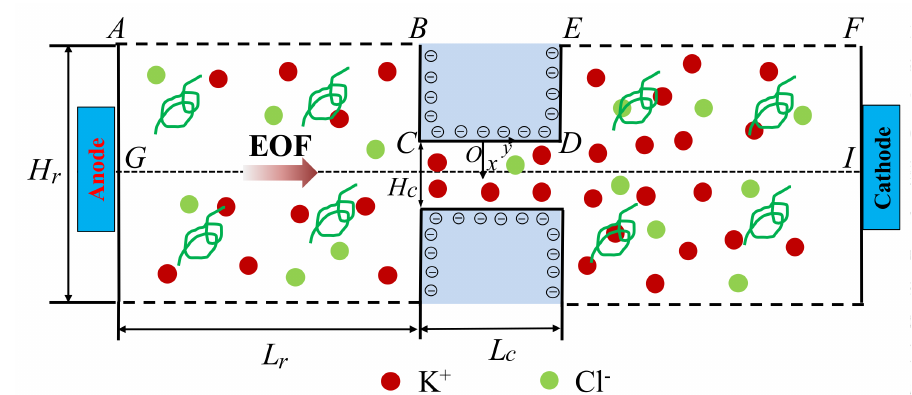
Figure 1. Schematic diagram of a nanochannel connecting two reservoirs at both ends. Uniform negative surface charges are distributed on the nanochannel wall and the adjacent walls of